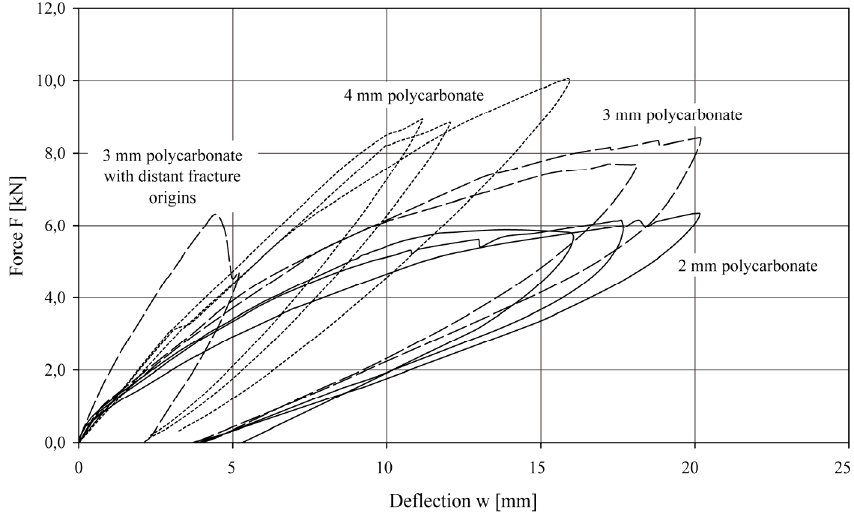
Figure 5: Load-deflection curves of composite beams with polycarbonate thicknesses of 4, 3 and 2 mm.